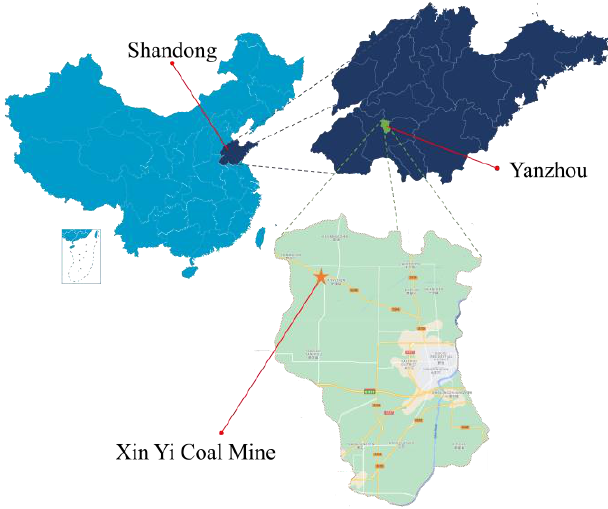
Figure 3. Geographical location of the coal mine.